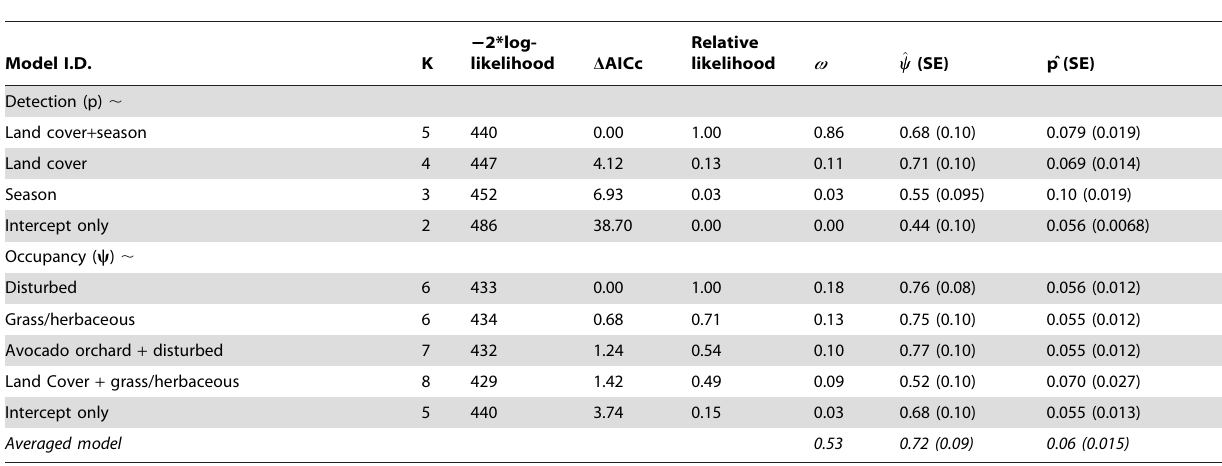
Table 2. Top-ranked models of site occupancy ( y ) and detection rate (p) for coyote.